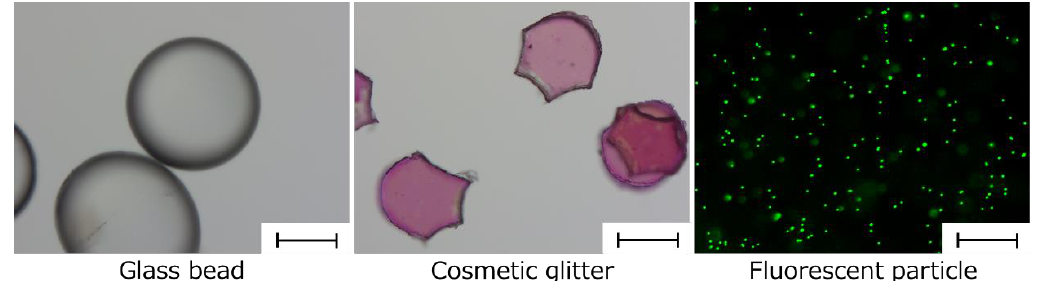
Figure 2. Photographs of target substances used for encapsulation. Scale bar: 200 µm.